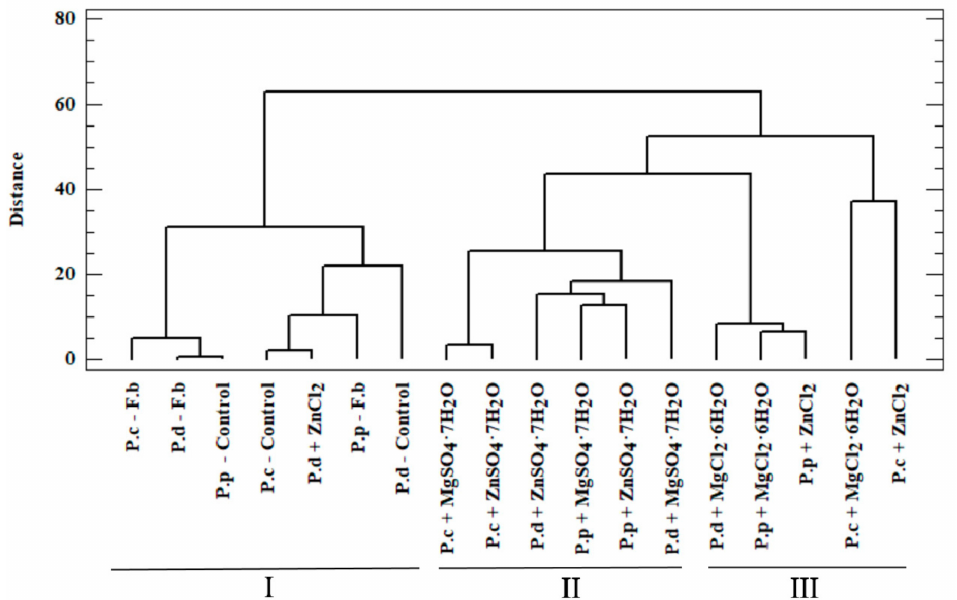
Figure 4. Dendrogram presenting similarity between the analyzed objects (Euclidean, City block algorithm) of added salts in liquid medium for the growth of mycelium from in vitro cultures of P.c— Pleurotus citrinopileatus , P.d— Pleurotus djamor , and P.p— Pleurotus pulmonarius , and Control— in vitro cultures without addition of salts. F.b—fruiting bodies.